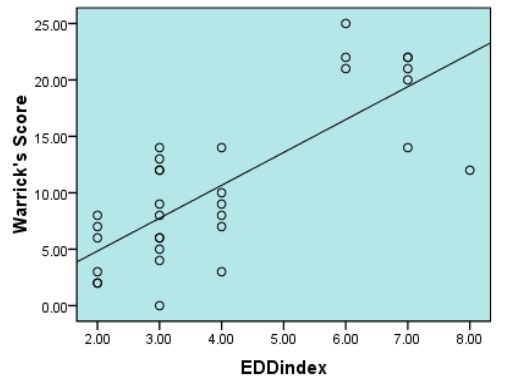
Figure 3. The correlation of Warrick score and skin sclerosis score in scleroderma lung patients (r= 0.8, P=